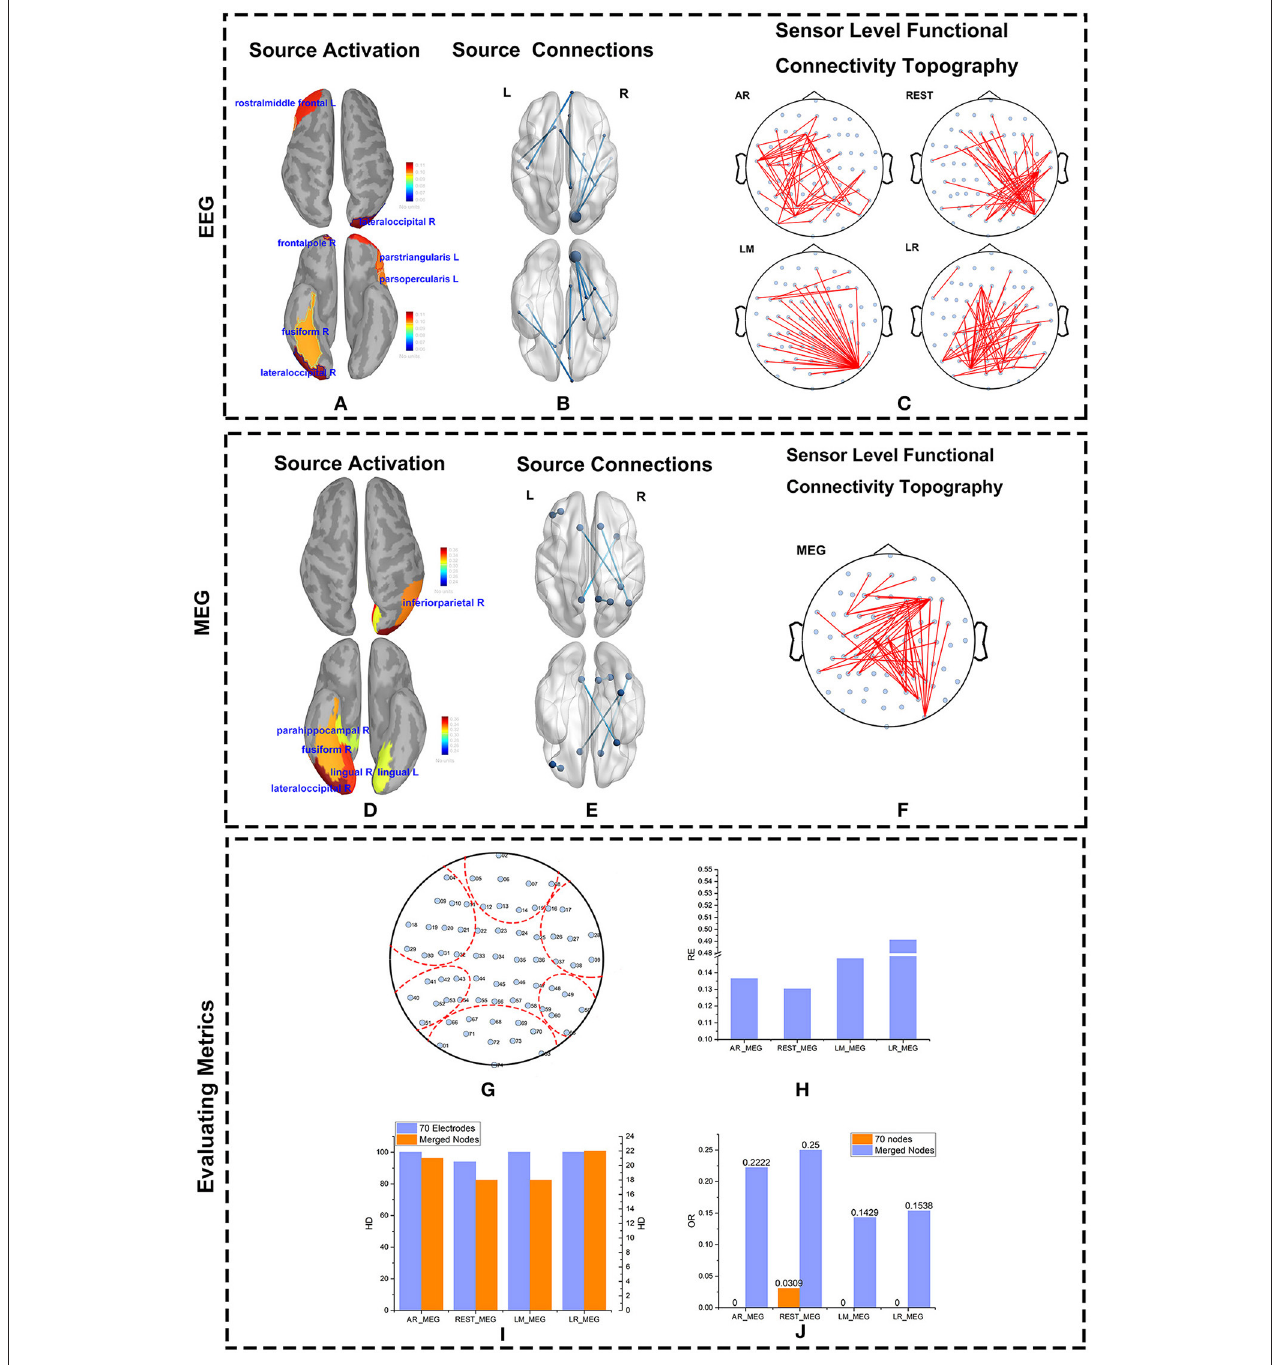
FIGURE 8 | Source and Scalp results from real data. The source activity for MEG and EEG were both reconstructed using Minimum Norm Imaging and model Dipole Orientations. The brain was divided into 68 scouts according to the Desikan-Killiany atlas. The source activity, source connections, and scalp functional connectivity topographies evaluated by EEG and MEG are illustrated. (A,D) Reconstructed source activity. The cortical activity is shown from above and below. The active areas are colored and labeled. (B,E) Connections at the source level from EEG (B) and MEG (E) are represented. The source connections are shown from above and below. The blue nodes represent scouts embedding strong activity. The blues lines denote the connections between two scouts. (C,F) Sensor-level functional connectivity topographies (sFCTs) from the four different reference schemes (C) and MEG (F) are represented. The blue nodes denote the distribution of electrodes, and the red lines represent the connections between electrodes. All sFCTs were constructed with network sparsity set to 50 edges. (G–J) Metric evaluations of seven electrode groups. (G) Electrode groups are shown encapsulated by the red dotted lines. (H) The RE (Relative Error) between each reference and MEG. (I) The HD (Hamming Distance) between each reference and MEG. (J) The OR (Overlapping Rate)between each reference and MEG.